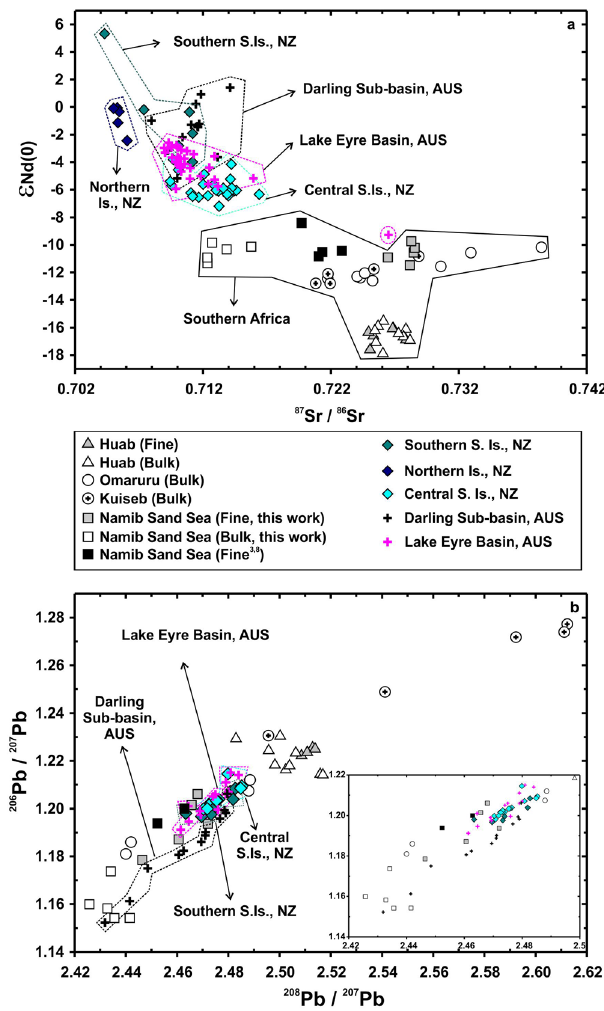
Fig. 5 Comparison of Southern Africa (SAF) with Australia (AUS) and New Zealand (NZ) geochemical signatures. a 87 Sr/ 86 Sr vs. ε Nd(0). b 208 Pb/ 207 Pb vs. 206 Pb/ 207 Pb. Lake Eyre Basin, AUS data from 13,21,24 ; Darling Sub-basin, AUS data from 8,84 ; NZ data from 3,24